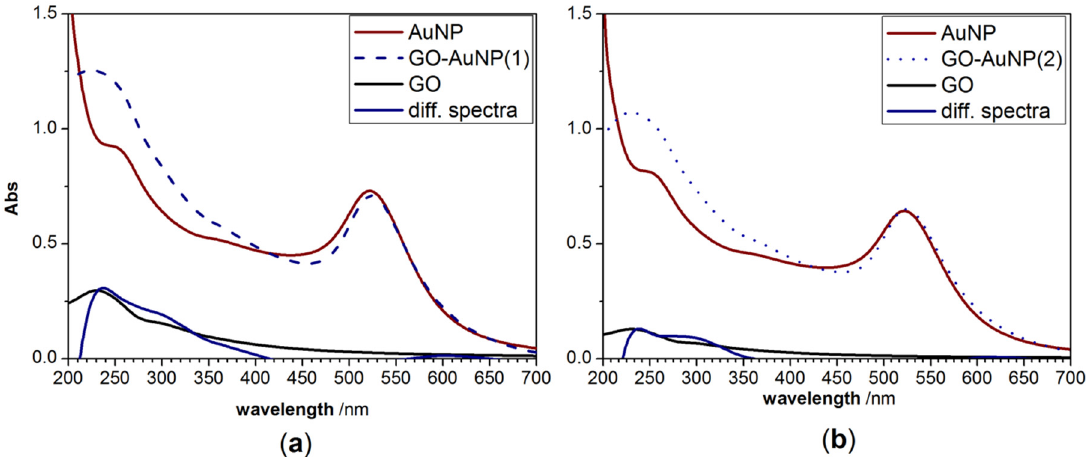
Figure 2. UV-visible experimental spectra of AuNP, GO, GO-AuNP ( a : pellet 1; b : pellet 2) and GO calculated spectrum by the difference (GO-AuNP)-(AuNP).